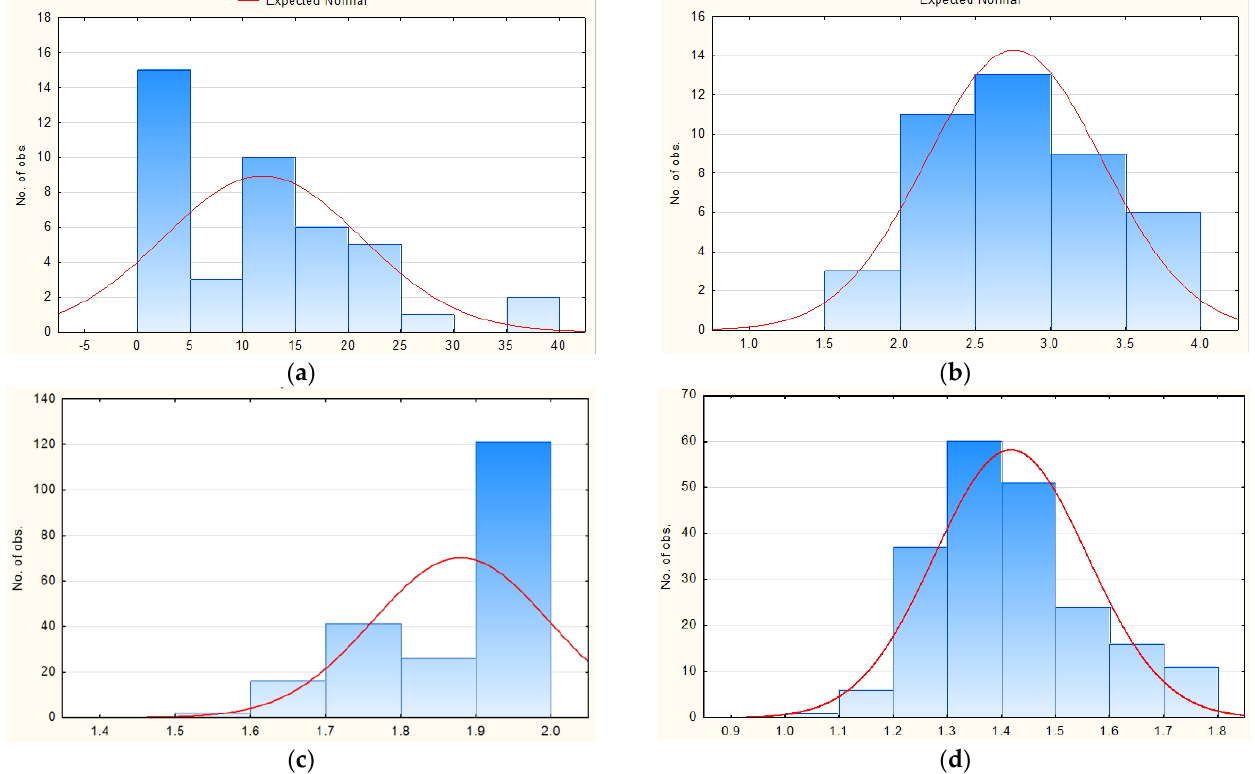
Figure 7. Histograms of ( a ) absorption; ( b ) density, and fractal dimension ( c , d ), obtained using ( c ) Find Edges tool and ( d ) the Canny Edge Detection plugin (K-S d ∼ = 0.15, p > 0.20, Lilliefors p < 0.05).